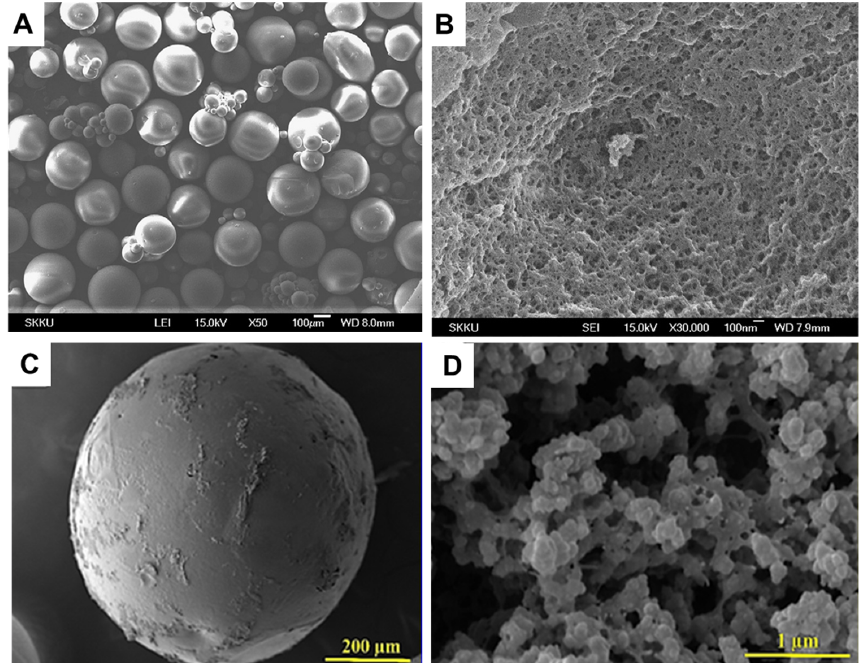
Figure 5. SEM micrographs of Cu(II) ‐ imprinted P(MAA ‐ co ‐ 4 ‐ VP) microparticles ( A ); internal morphology of Cu(II) ‐ imprinted P(MAA ‐ co ‐ 4 ‐ VP) microparticles ( B ) (reproduced with permission phology of Cu(II)-imprinted P(MAA- co -4-VP) microparticles ( B ) (reproduced with permission from from Ref. [52]. Copyright 2010 Elsevier); SEM micrographs of Cu(II) ‐ imprinted P(MMA ‐ co ‐ PA) Ref. [52]. Copyright 2010 Elsevier); SEM micrographs of Cu(II)-imprinted P(MMA- co -PA) beads ( C ); beads ( C ); internal morphology of Cu(II) ‐ imprinted P(MMA ‐ co ‐ PA) beads ( D ) (reproduced with internal morphology of Cu(II)-imprinted P(MMA- co -PA) beads ( D ) (reproduced with permission permission from Ref. [56]. Copyright 2020 Elsevier). from Ref. [56]. Copyright 2020